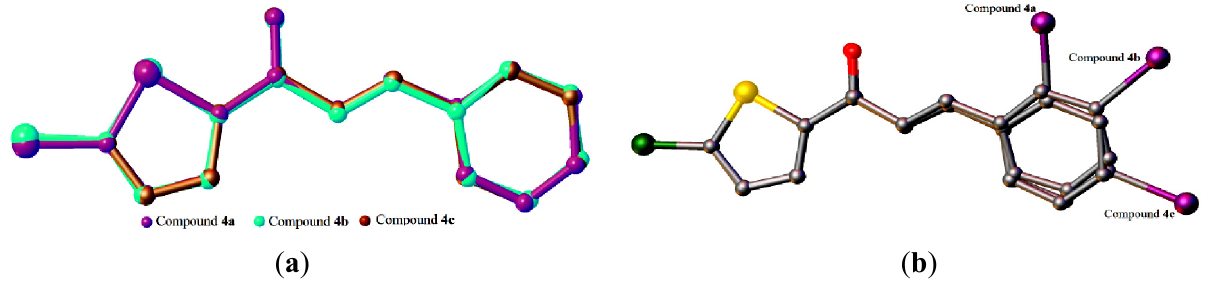
Figure 3. ( a ) Overlay of all non-H atoms, calculated using the chlorothiophene moiety. Molecule B in 4a and the iodine substituents in all three compounds were excluded in the overlay. ( b ) Overlays were calculated using the chlorothiophene moiety in compounds 4a , 4b and 4c . Hydrogen atoms have been omitted for